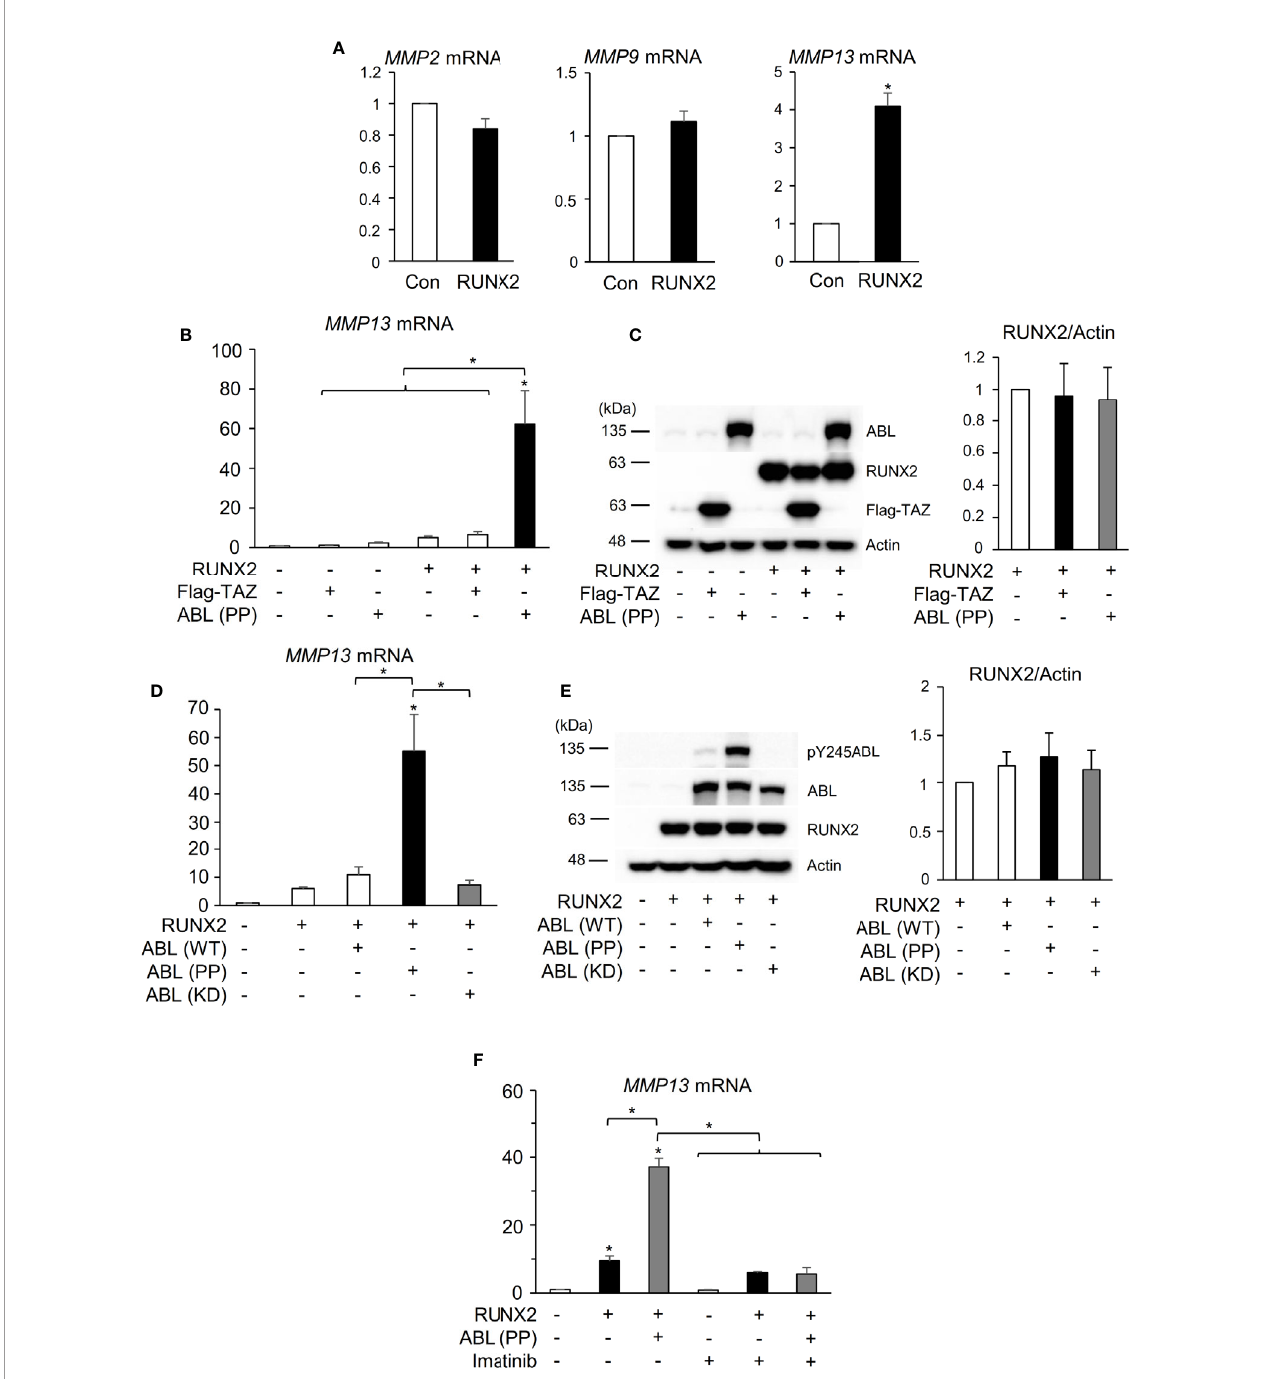
FIGURE 1 | ABL kinase activity is required for RUNX2-mediated MMP13 expression. (A) Quantitative PCR analysis of MMP2, 9, and 13 mRNA expression in HEK293T cells transfected with RUNX2. n = 3. (B) Quantitative PCR analysis of MMP13 mRNA expression in HEK293T cells co-transfected with RUNX2 with or without TAZ or ABL (PP). n = 3. (C) HEK293T cells were co-transfected with RUNX2 with or without TAZ or ABL (PP). Whole cell lysates were probed with the indicated antibodies for Western blot analysis. (D) Quantitative PCR analysis of MMP13 mRNA expression in HEK293T cells co-transfected with RUNX2 with or without ABL (WT, PP or KD). n = 3. (E) HEK293T cells were co-transfected with RUNX2 with or without ABL (WT, PP or KD). Whole cell lysates were probed with the indicated antibodies for Western blot analysis. (F) Quantitative PCR analysis of MMP13 mRNA expression in HEK293T cells co-transfected with RUNX2 with or without ABL (PP) and cultured in the presence or absence of 10 m M imatinib for 24 hours. n = 3. P values were determined by the unpaired t-test (A) or ANOVA with Tukey – Kramer ’ s post hoc test (B – F) . Data are presented as means ± SEM. *P <